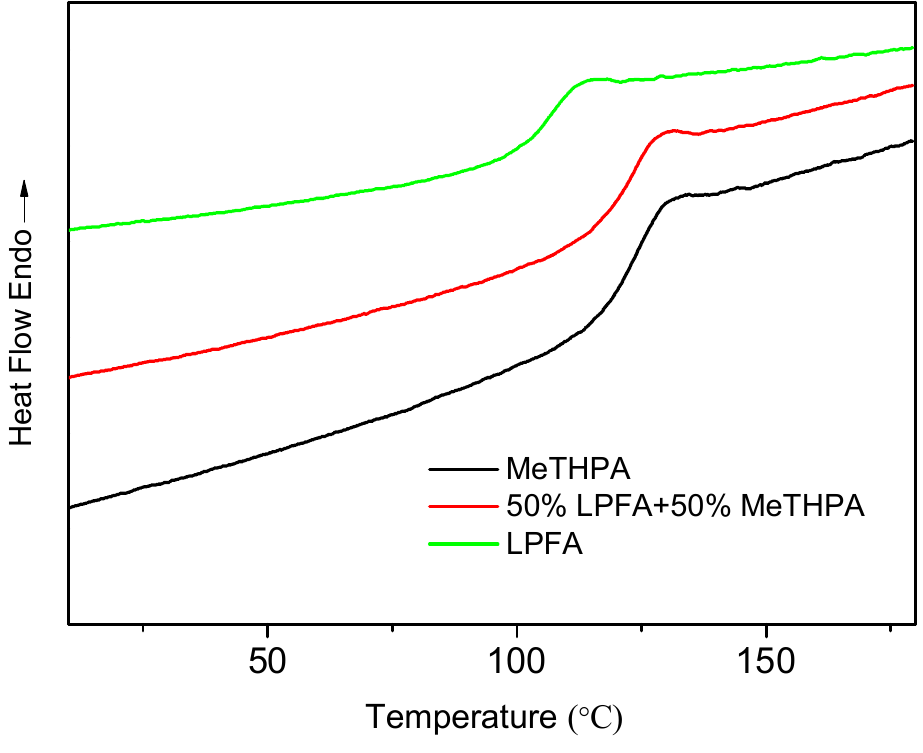
Figure 6. DSC of the cured epoxy resins.